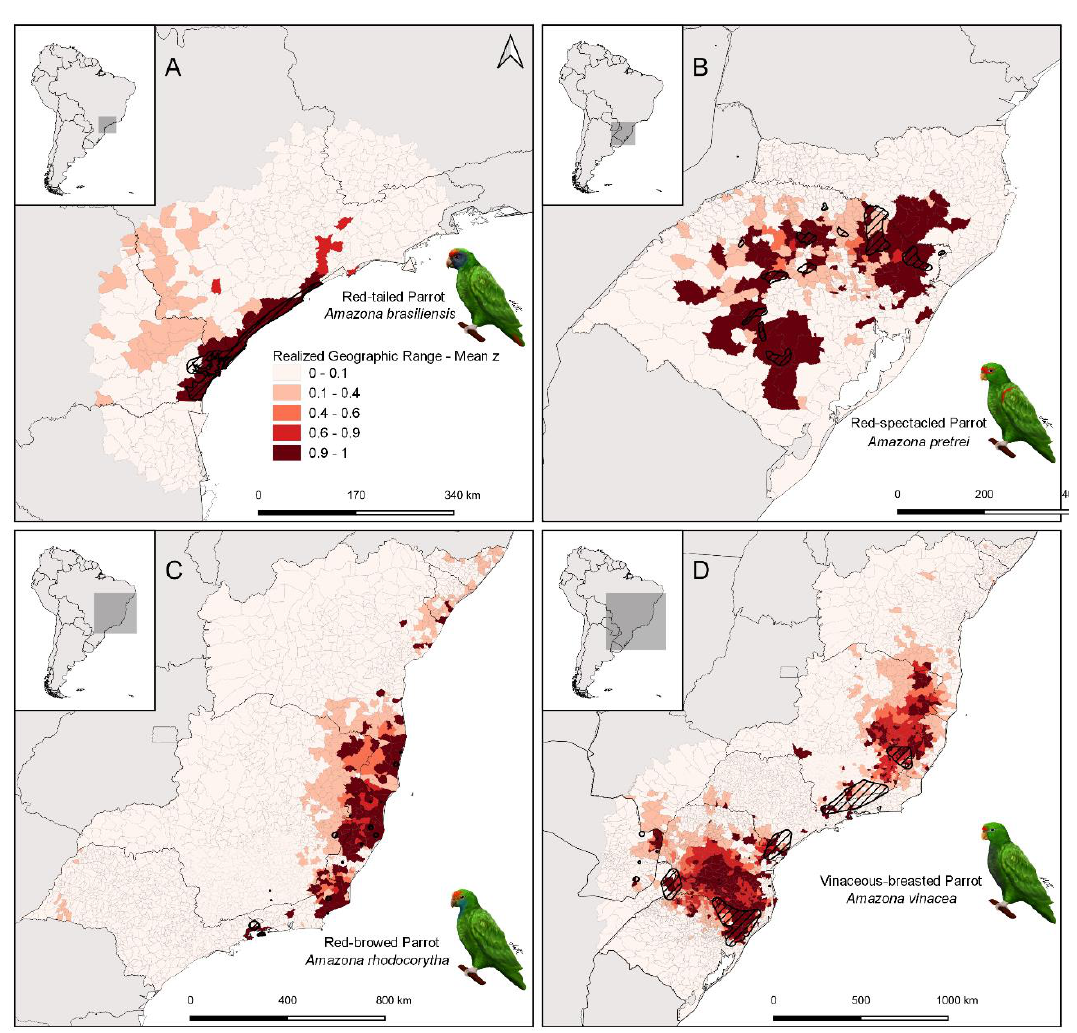
Figure 1. Geographic ranges of the four study species represented by the mean of the true occupancy state ( 𝑧 ) estimated for each municipality. Intermediate values—of 𝑧~0.5 —indicate the highest uncertainty about occupancy by each species. Black dashed polygons are the Extant range of each species according to the IUCN Red List of Threatened Species [1].